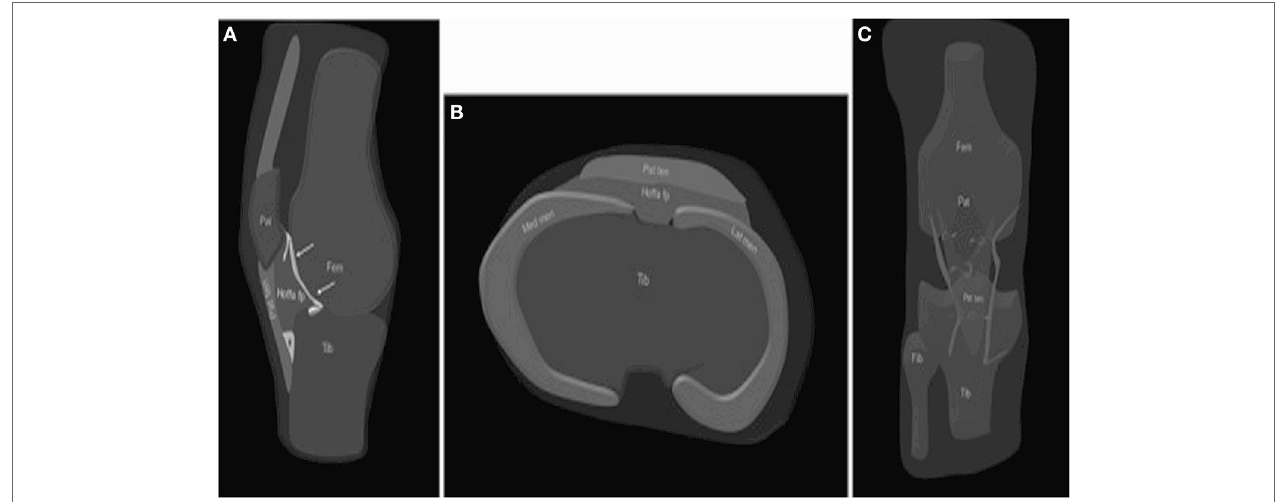
FiGUre 1 | Anatomy of the HFP. The HFP ( Hoffa fp ) is limited anteriorly by the patellar tendon (PT) ( Pat ten ) and the joint capsule, superiorly by the inferior pole of the patella ( Pat ) (a) , inferiorly by the proximal tibia ( Tib ) and the deep infrapatellar bursa ( asterisk ), and posteriorly by the synovium ( arrows ) and femur ( Fem ). It is attached directly to the anterior horns of the menisci ( Med men , Lat men ) (B) . Normal vascular supply consists of two vertical arteries, posterior and parallel to the lateral edges of the PT (C) . Courtesy of Draghi et al. from Insights into Imaging 2016